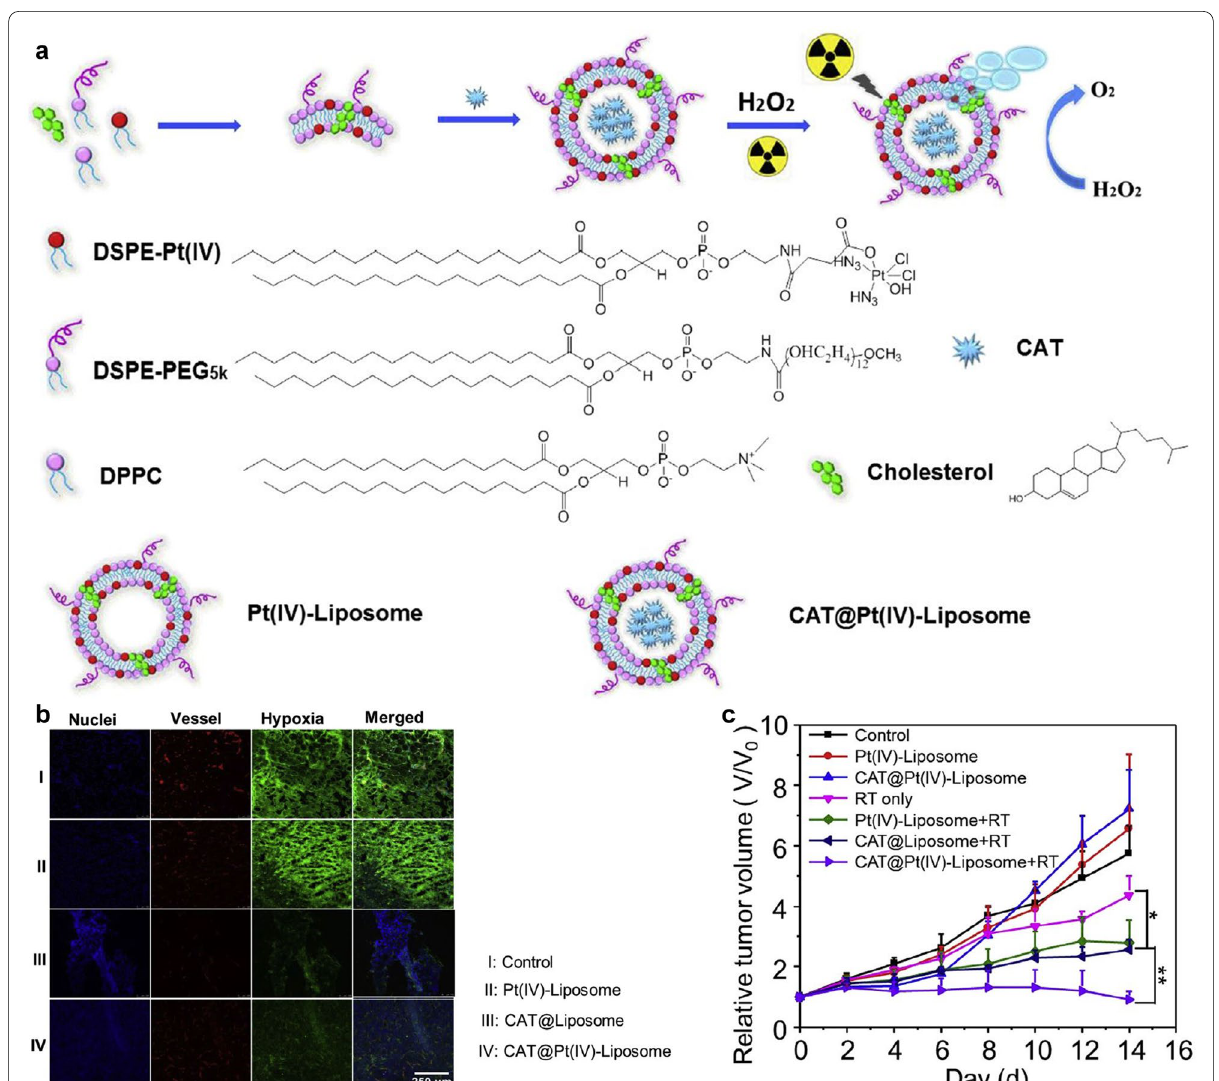
Fig. 7 a A scheme showing the preparation of CAT@Pt(IV)-liposomes for tumor hypoxia relieved cancer chemo-RT. b Ex vivo immunofluorescence staining of tumor slices collected from mice with intravenous injection of saline, Pt(IV)-liposomes, CAT@liposomes, or CAT@Pt(IV)-liposomes at 24 h. c Tumor growth curves of mice after various different treatments indicated. Reproduced with permission from [87]. Copyright 2017,